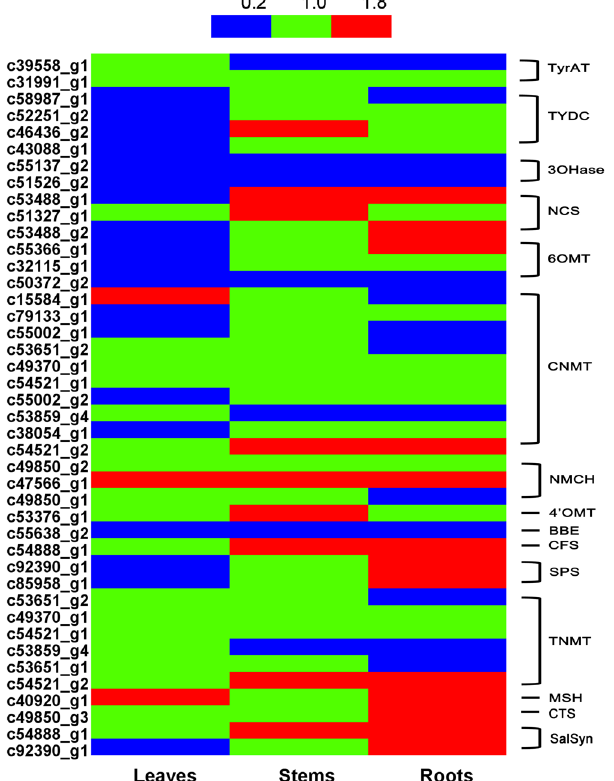
Figure 4. RPKM values of candidate unigenes involved in the biosynthesis of IQAs in D . scandens . Expression levels of candidate unigenes involved in the biosynthesis of IQAs in D . scandens leaves, stems and